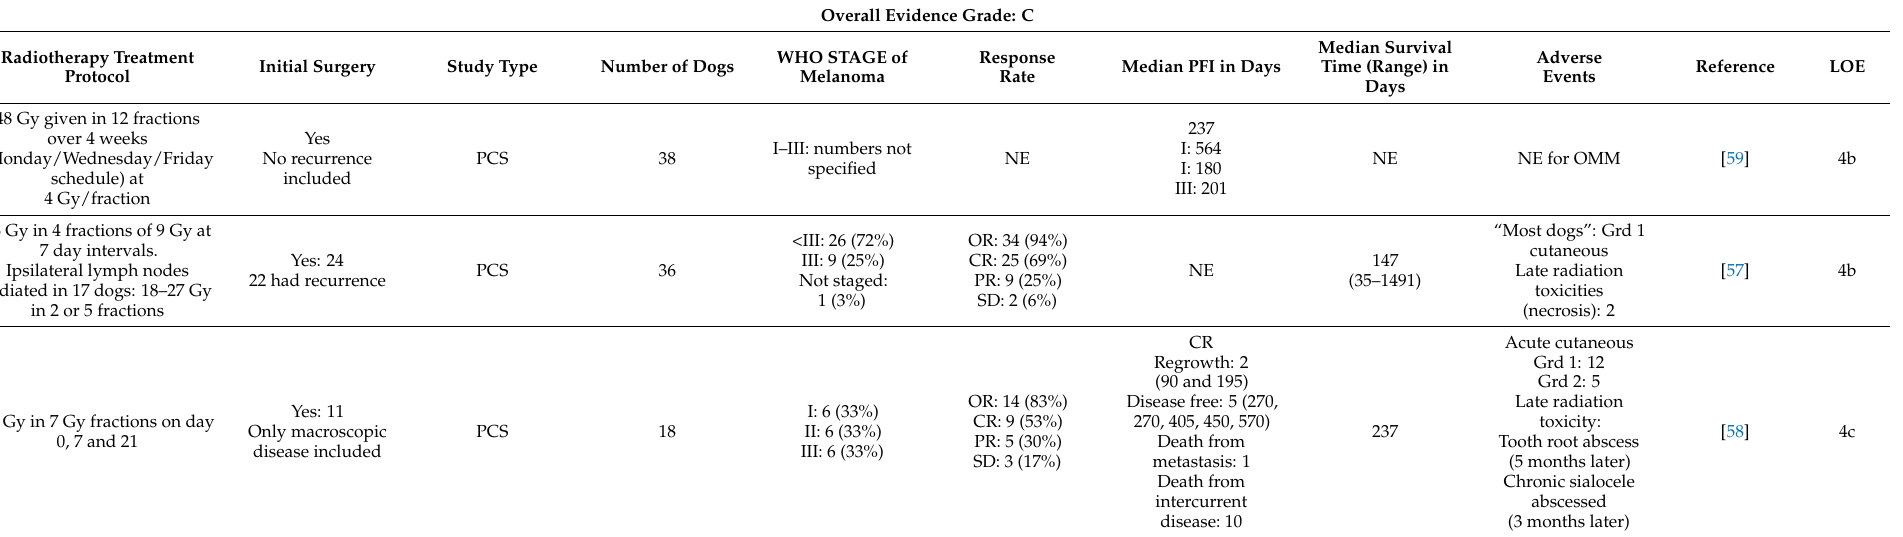
Table 5. Summary of radiotherapy without adjunctive therapy studies evaluating effectivity in oral malignant